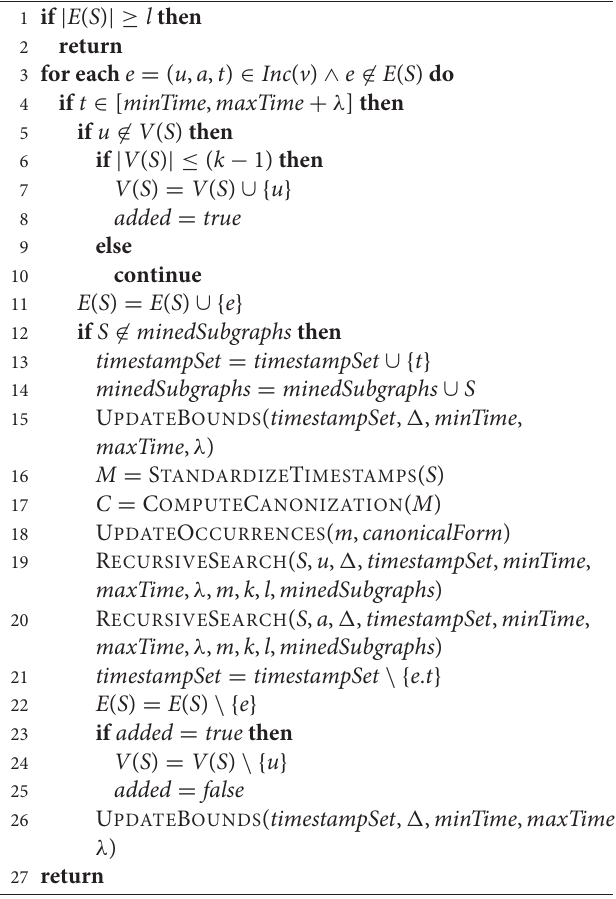
Algorithm 3 | R ECURSIVE S EARCH ( S , a , 1 , timestampSet